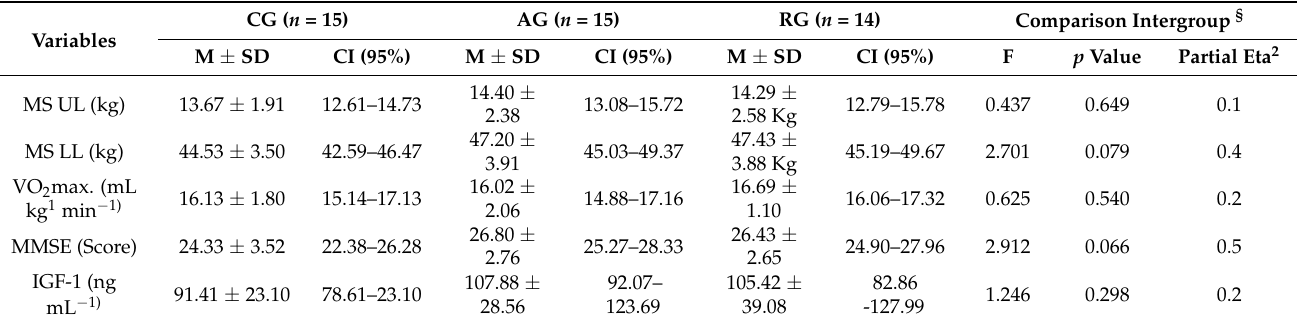
Table 3. Intergroup comparison of aerobic capacity (VO 2 max), maximum muscular strength (MS) of upper limbs (UL), lower limbs (LL), cognitive state (MMSE), and growth factor concentration (IGF-1). Pre-test. Variables